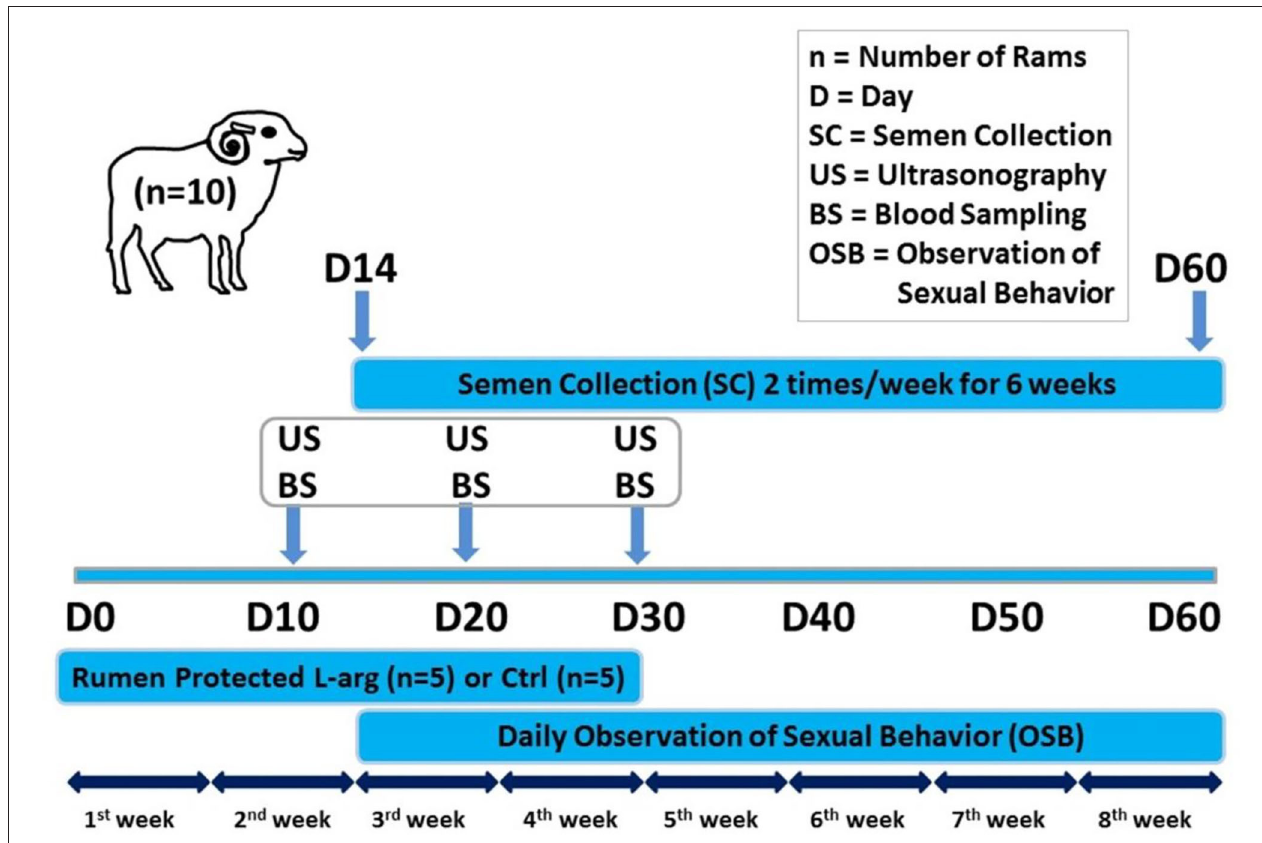
FIGURE 1 | Schematic diagram showing the experimental protocol for the effect of oral administration of rumen-protected L-arginine on the testes and accessory genital glands of rams. Rumen-protected L-arginine was supplemented for 30 days (D0: day of the start of supplementation). Ultrasonography and blood sampling for further biochemical and hormonal assays were performed on D10, D20, and D30. Ram sexual behavior was daily observed and collection of ram semen (2 times/ week) was done starting from D14 until